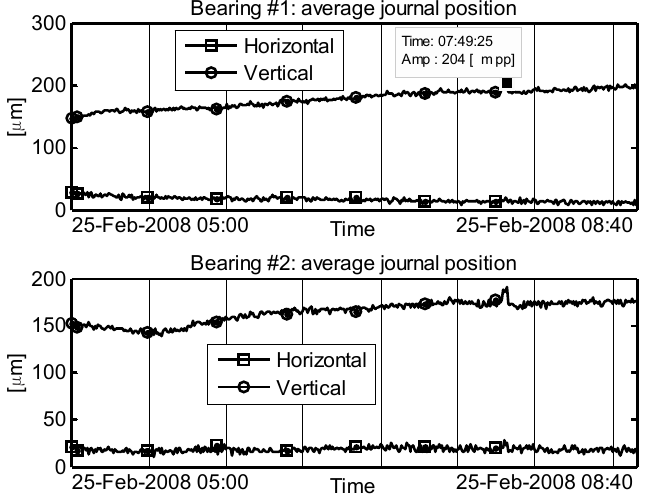
Fig. 12. Historic trend of the horizontal and vertical components of the average position of the journal inside bearings #1 and #2 measured in operating condition during a load